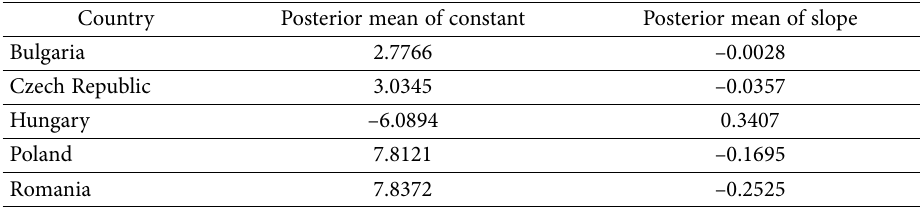
Table 4. Bayesian linear regression models for explaining GDP rate in CEE-5 countries Country Posterior mean of constant